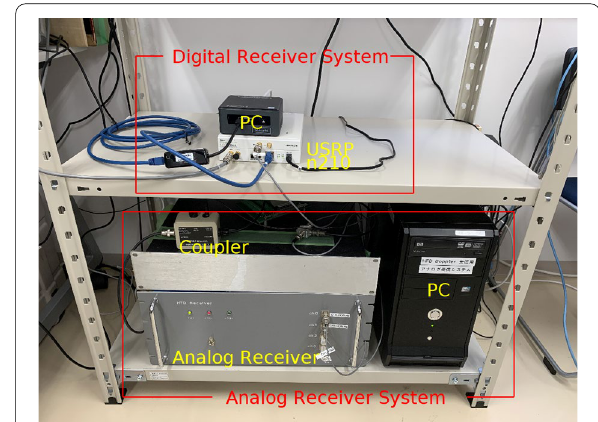
Fig. 8 Photo of the digital (top side) and analog (bottom side) receiving systems in Awaji